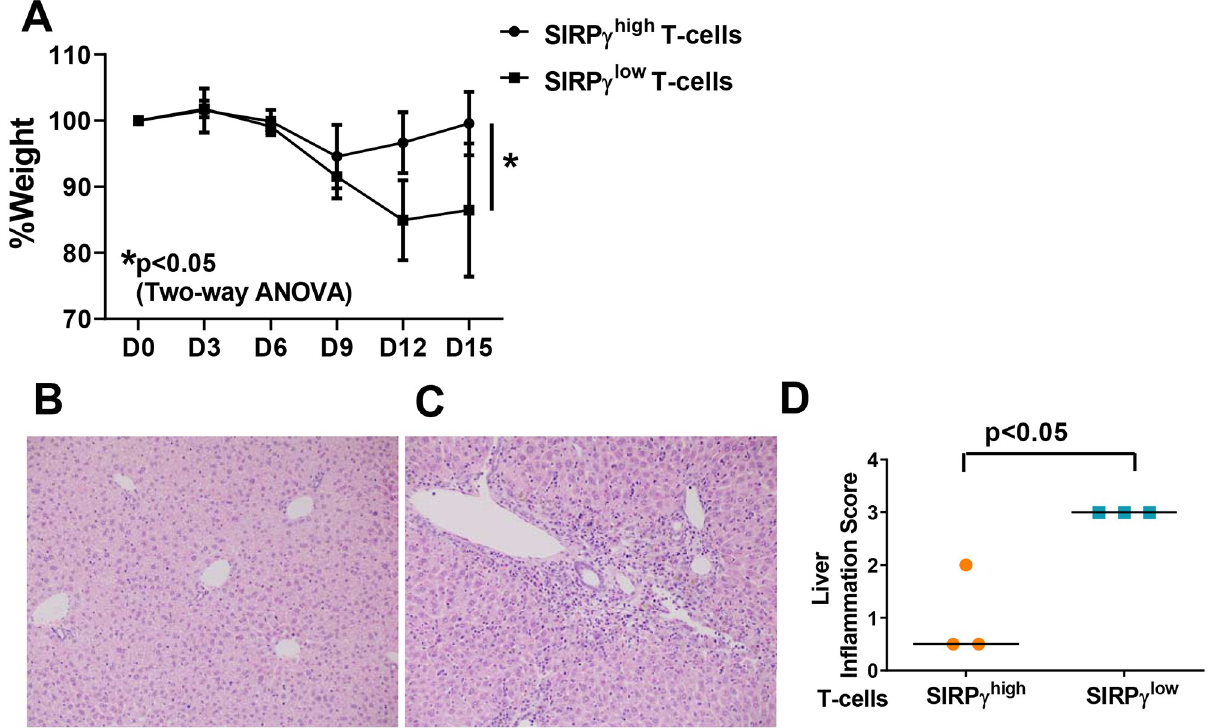
Fig 5. Unlike SIRP γ high T-cells, sub-optimal numbers of SIRP γ low T-cells are sufficient to cause xenoGVHD in NSG mice. Three million SIRP γ high T-cells or SIRP γ low T-cells, from 3 separate CC or TT carriers, were transferred into NSG mice. Weight was monitored as shown in A. Representative H&E staining on liver tissues is shown in B. Liver inflammation was scored by a pathologist blinded to the experimental grouping, using a previously published, established scale. Two-way ANOVA with Bonferroni’s multiple comparison test was performed to compare weight loss and p < 0.05 was considered significant. An unpaired t-test was performed to compare inflammation scores and p < 0.05 was considered significant.